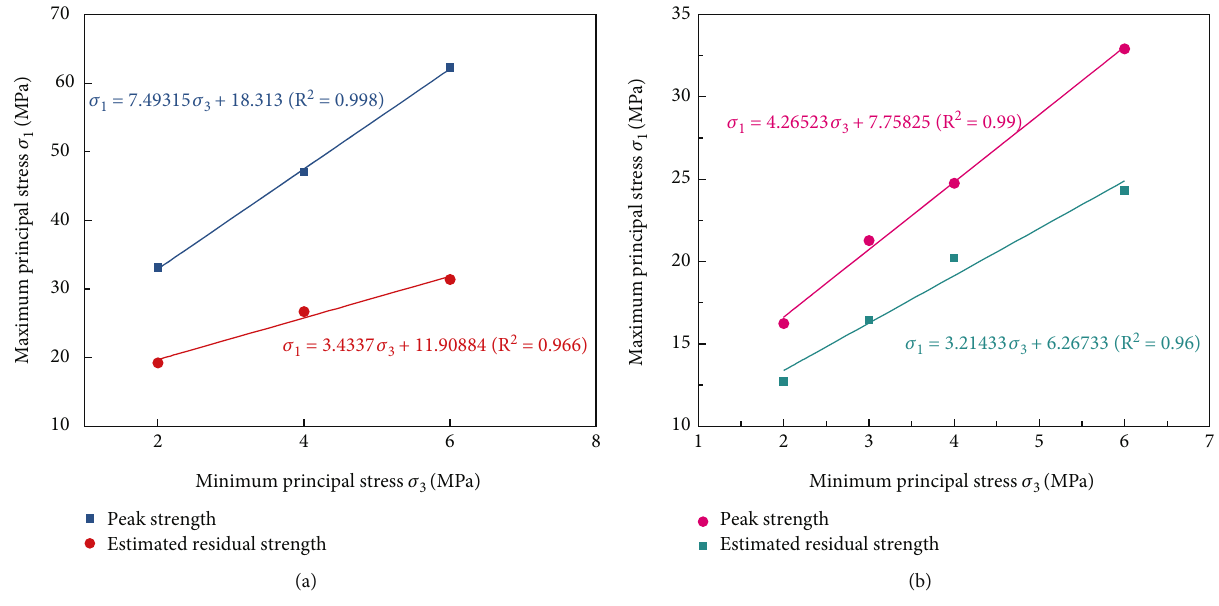
Figure 13: Linear fi tting of strength values: (a) raw coal and (b) briquette composed of soft coal. Table 7: Numerical simulation parameters.